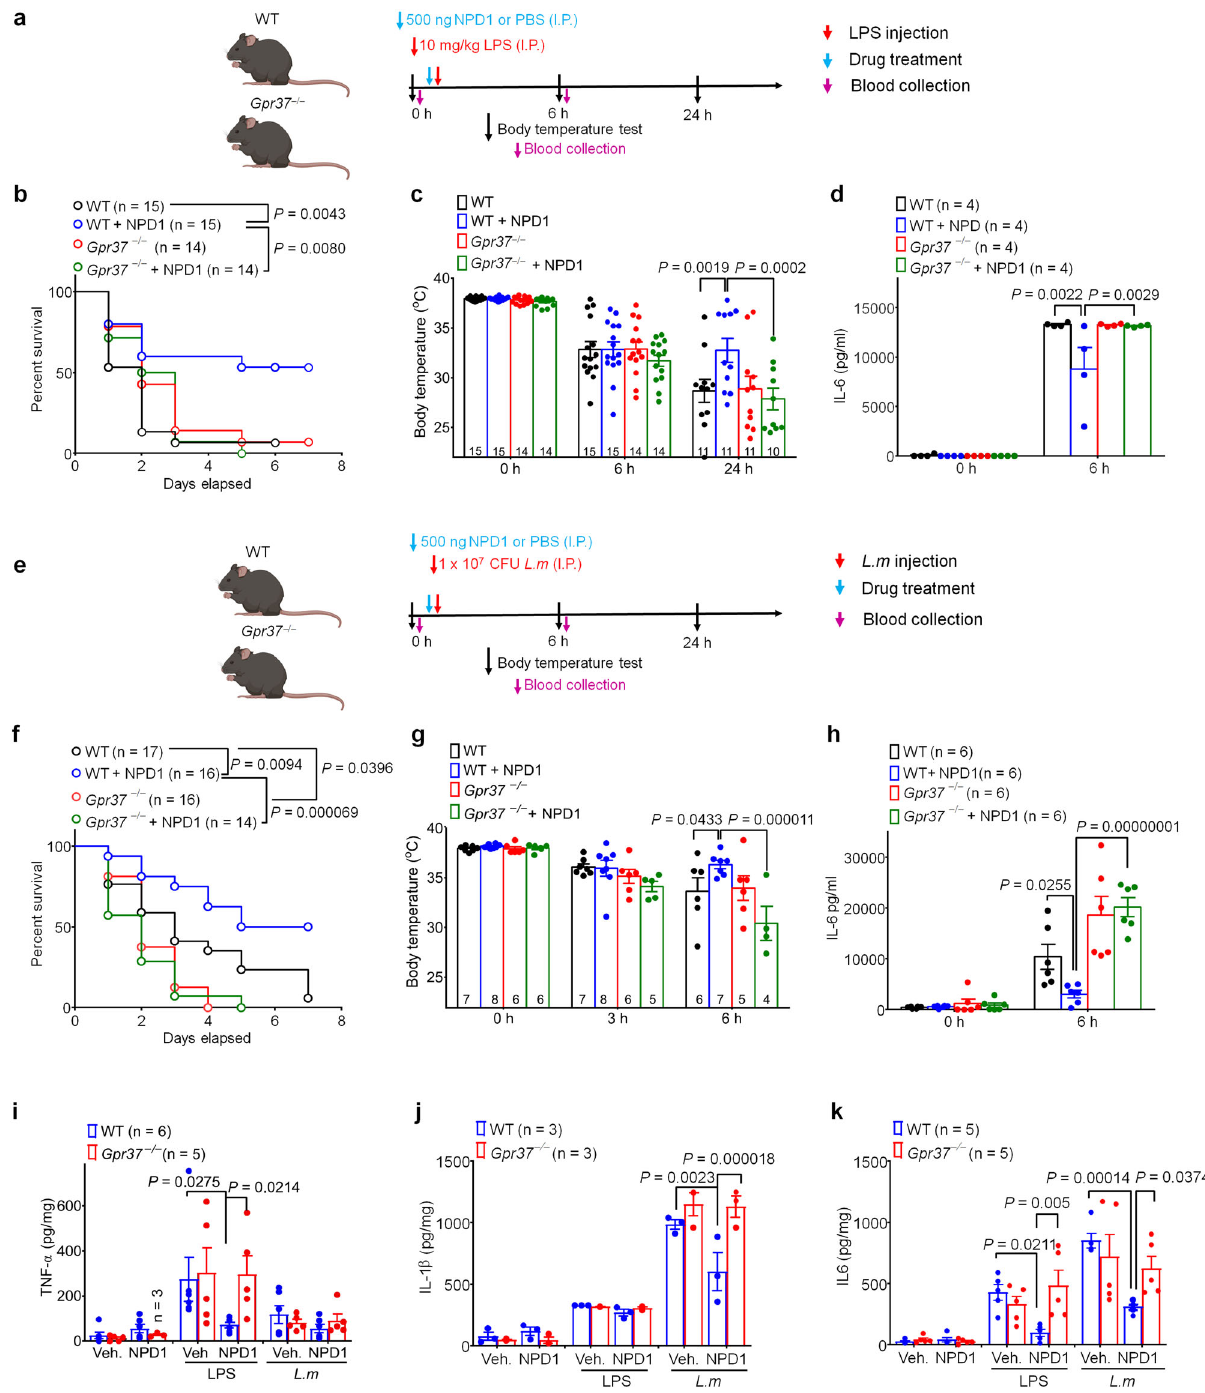
Fig. 1 Protection of LPS- and L. monocytogenes- induced sepsis by GPR37. a Experimental design for the LPS model. Wild-type (WT) mice and Gpr37 − / − mice were given intraperitoneal (I.P.) injection of LPS (10 mg/kg) together with vehicle or NPD1 (500 ng, I.P.) treatment. b Survival curves of WT and Gpr37 − / − mice treated with vehicle or NPD1. Sample sizes are indicated in brackets. c Time course of rectal temperature in WT and Gpr37 − / − mice. Sample sizes are indicated in columns. d Serum IL-6 levels in WT and Gpr37 − / − mice ( n = 4/group). e Experimental design for Listeria monocytogenes ( L. m , 10 7 , I.P) inoculation in WT and Gpr37 − / − mice, together with treatment of vehicle or NPD1 (500 ng, I.P.). f Survival curves of WT and Gpr37 − / − mice treated with NPD1 or Vehicle. Sample sizes are indicated in brackets. g Time course of rectal temperature in WT and Gpr37 − / − mice with vehicle or NPD1 treatment. h Serum IL-6 levels in WT and Gpr37 − / − mice 6 h after L . m injection ( n = 6). i – k Cytokine levels in culture media of pM Φ from WT or Gpr37 mice. pM Φ cultures were treated with LPS (1 μ M, 37 °C, 12 h) or L. m (1 × 10 4 CFU, 37 °C, 12 h) together with vehicle (Veh.) or 30 nM NPD1 (30 nM). ELISA was tested for TNF- α ( i ), IL-1 β ( j ), and IL-6. k Data are expressed as mean ± s.e.m. and statistically analyzed by Mantel – Cox test ( b , f ), Two-way ANOVA followed by Tukey ’ s posthoc test ( c , d , h ) Bonferroni ’ s post hoc test ( i – k ).